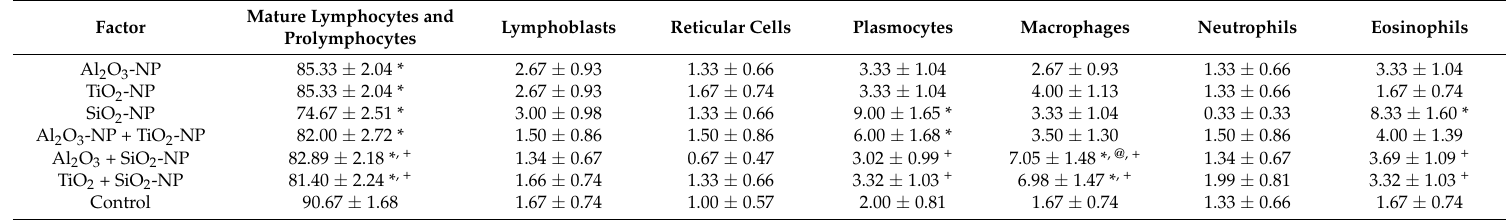
Table 10. Some Cytological Characteristics of Mesenteric Tissue Imprints as a Percentage of Total Cell Count in Rats after Subchronic Exposure to Al 2 O 3 -NP, TiO 2 -NP and SiO 2 -NP Individually or in Binary Combinations (x ± s.e.).